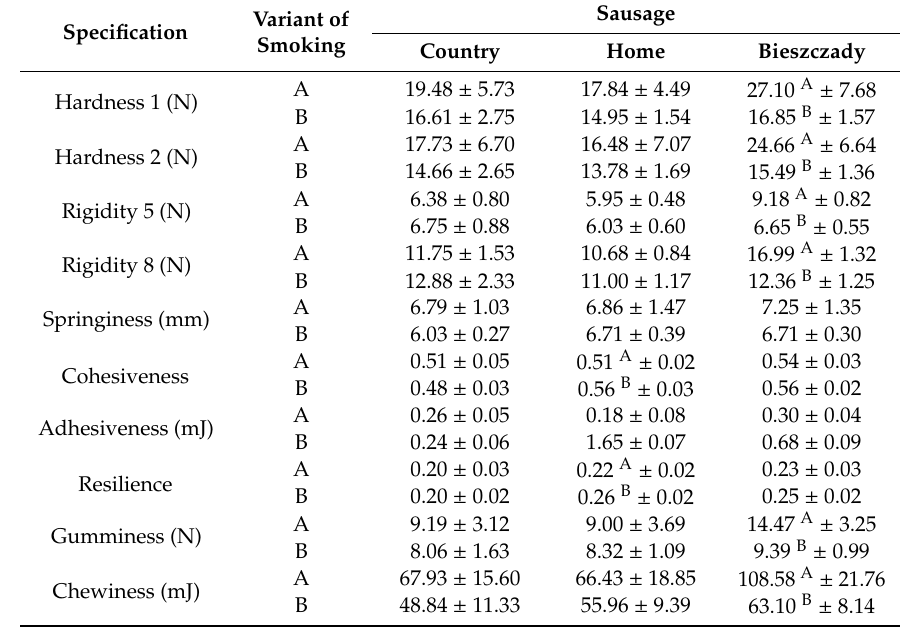
Table 1. Texture parameters of medium-ground sausages (2 samples × 10 batches × 2 variants × 3 types of sausages = 120 sausage samples) (average values ( x ) ±